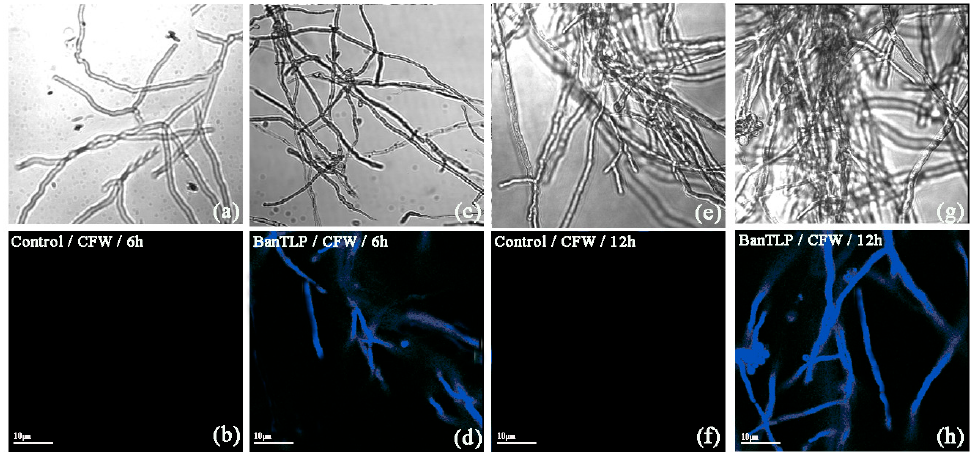
Figure 5. Effect of BanTLP at 60 μ M on the cell wall integrity of P. expansum conidia. The Calcofluor White (CFW) fluorescent probe was visualized with the aid of fluorescence microscopy in P. expansum conidia treated with distilled water for 6 h ( a , b ) and 12 h ( e , f ) or treated with BanTLP for 6 h ( c , d ) and 12 h ( g , h ). Upper panels display the bright field images, while lower panels display the corresponding fluorescence images for the same field. The scale bar represents 10 μ m.